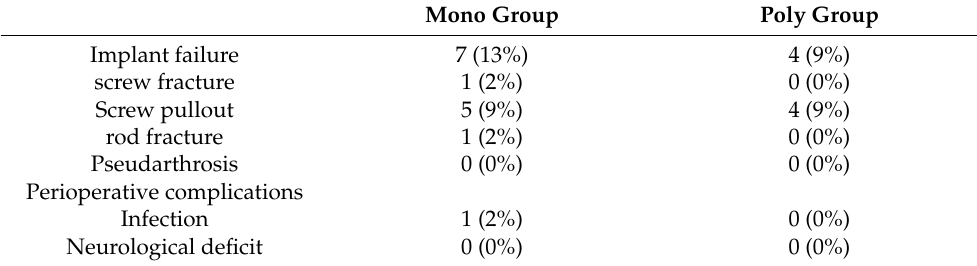
Table 4. Summary of complications.